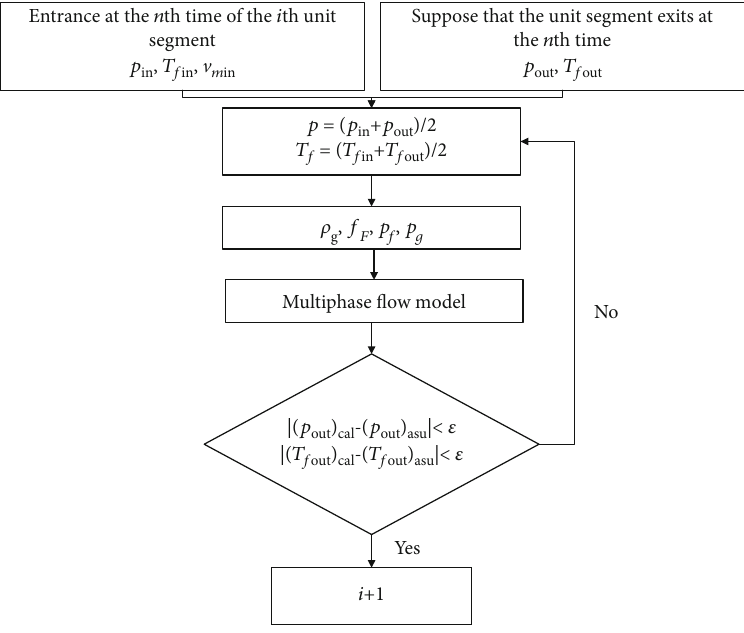
Figure 2: Flowchart for model